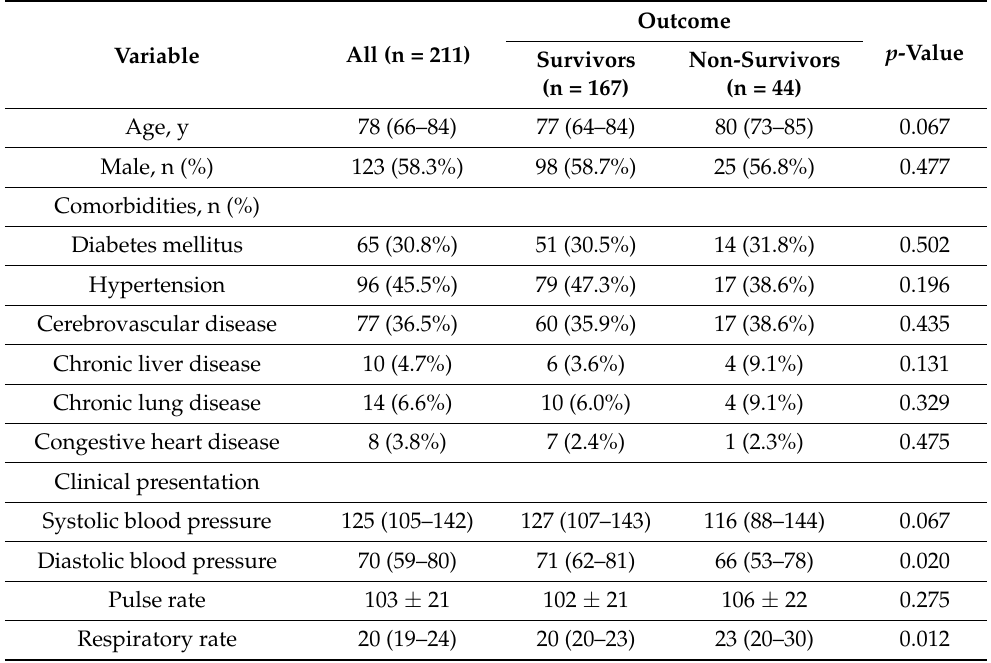
Table 1. Demographics and clinical characteristics of the enrolled CAP patients.